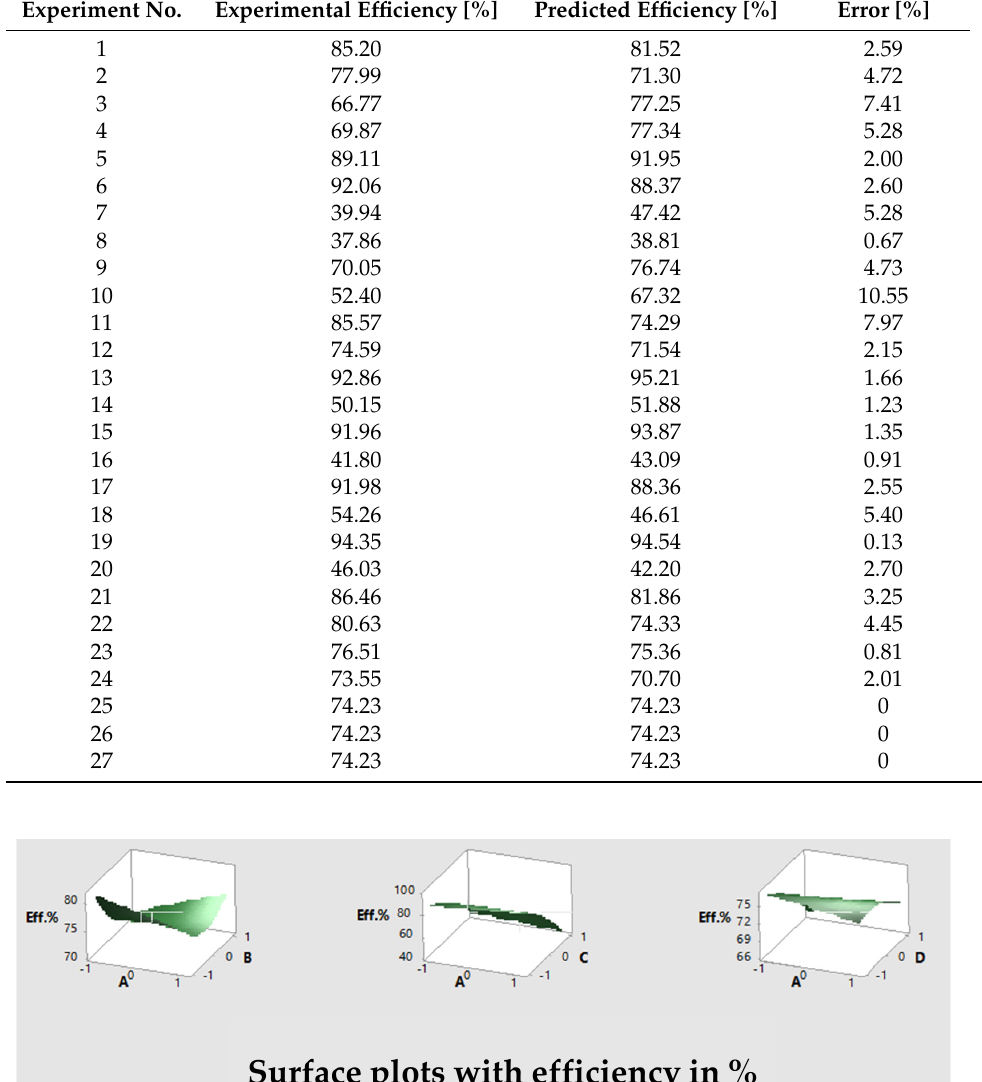
Surface plots with efficiency in %